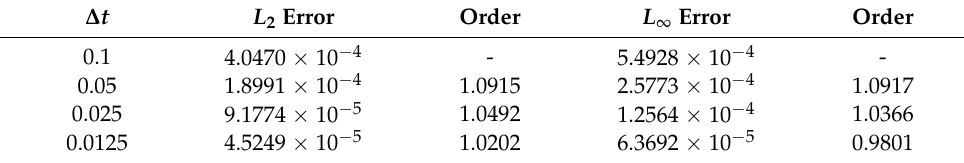
Table 3. The truncation error and convergence order of concentration C with ∆ y =